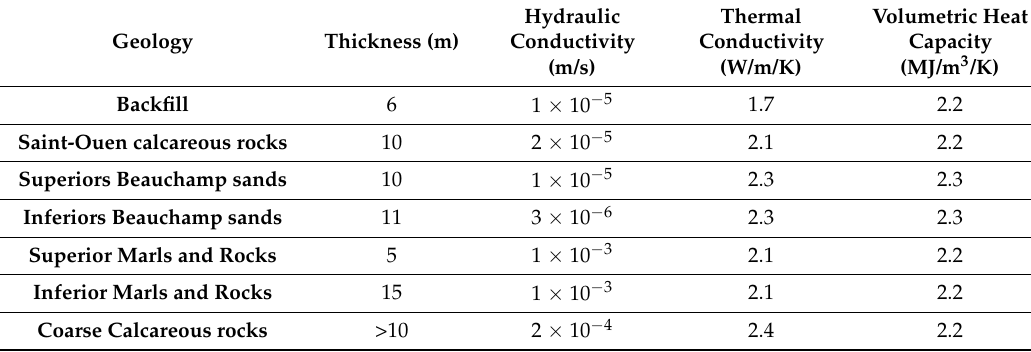
Table 3. Geology and thermo-hydraulic material